Question: Does the plotted quantity increase or decrease?
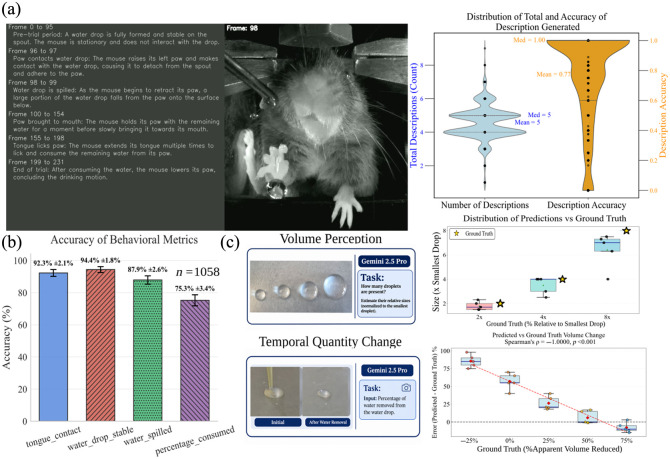
Answer: decreasing